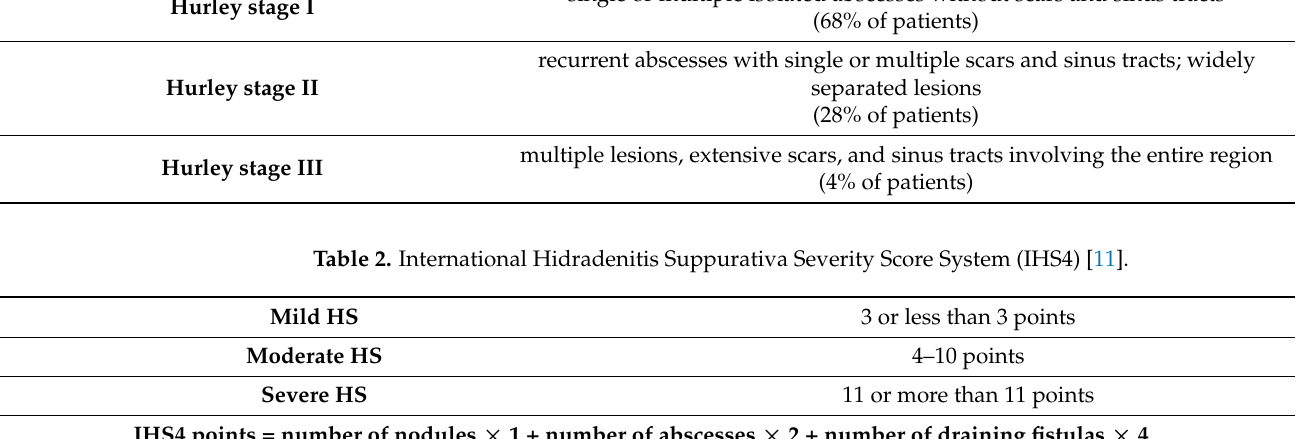
Abbreviations: HS: Hidradenitis